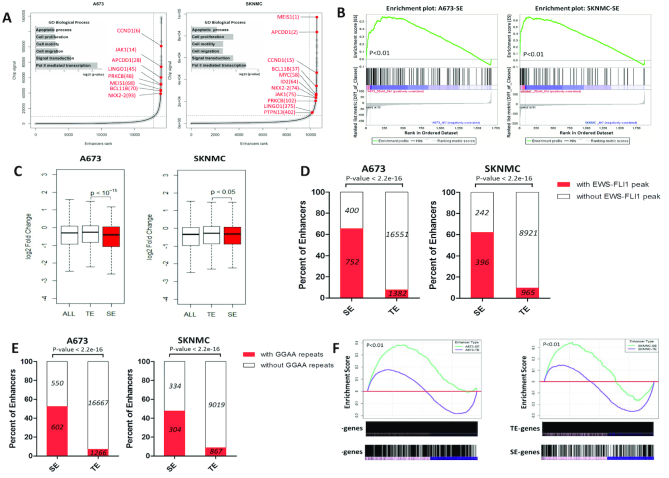
Profiling of super-enhancer landscapes in Ewing sarcoma cell lines, (A) Hockey stick plots showing rank order of H3K27ac signals for all enhancers in A673 and SKNMC cells. Inserted panels showing selected GO functional categories of super-enhancer-associated genes. (B) Gene Set Enrichment analysis (GSEA) of the fold changes of super-enhancer (SE)-associated transcripts following treatment with 50 nM THZ1 for 6 h in A673 and SKNMC. (C) Box plots showing log2 fold changes of transcripts associated with typical-enhancer (TE) and SE upon 50 nM THZ1 treatment for 6 h in A673 and SKNMC. (D, E) Pearson's Chi-squared tests showed SE regions had significantly more (D) EWS-FLI1 binding peaks and (E) motif (GGAA repeats) than TE regions. EWS-FLI1 ChIP-seq data are publicly accessible on NCBI GEO under the accession number ‘GSE61953′. (F) GSEA of the fold changes of either SE- or TE-associated transcripts upon EWS-FLI1 depletion (48 hr) in A673 and SKNMC cells. Gene expression data for A673 and SKNMC cells in either the presence or absence of EWS-FLI1 knockdown were also obtained from NCBI GEO (GSE61953).